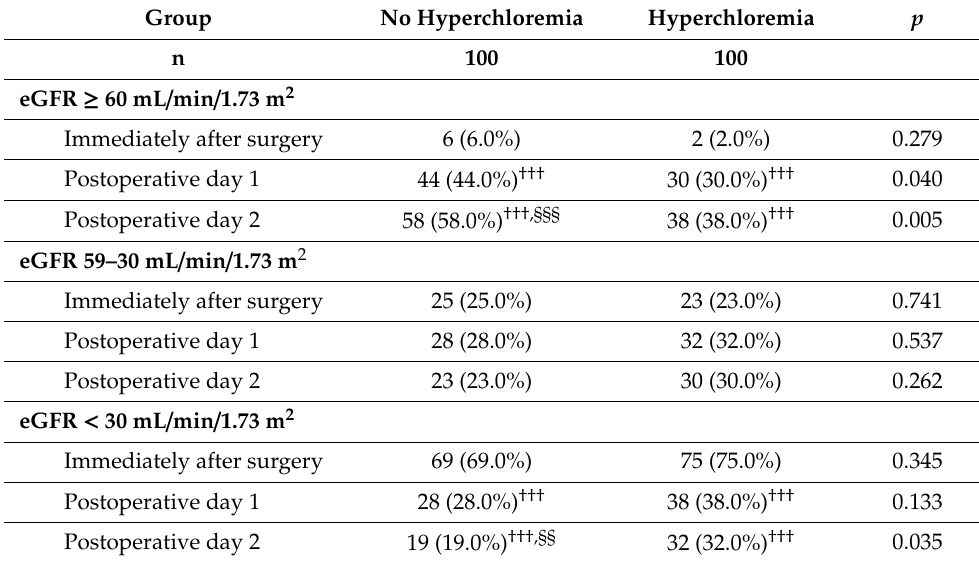
Table 5. Comparison of kidney graft function according to estimated glomerular filtration rate during postoperative day 2 between propensity score-matched non-hyperchloremia and hyperchloremia groups.